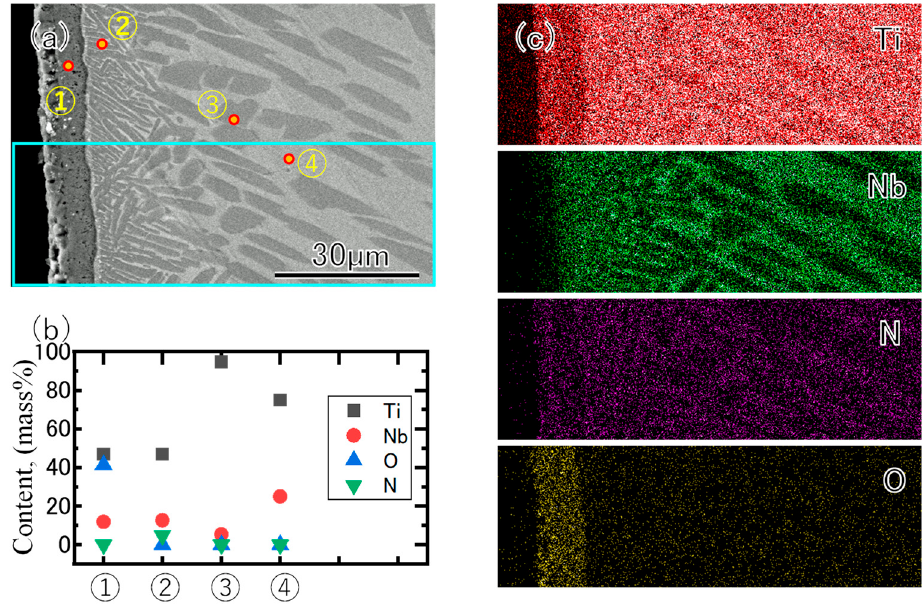
Figure 5. Cross-sectional SEM-EDX analysis results after GNQP at 1223 K. ( a )SEM microstructure. ( b ) The result of point analysis at the position indicated by the number of ( a ). ( c ) The element mapping results of Ti, Nb, N and O.